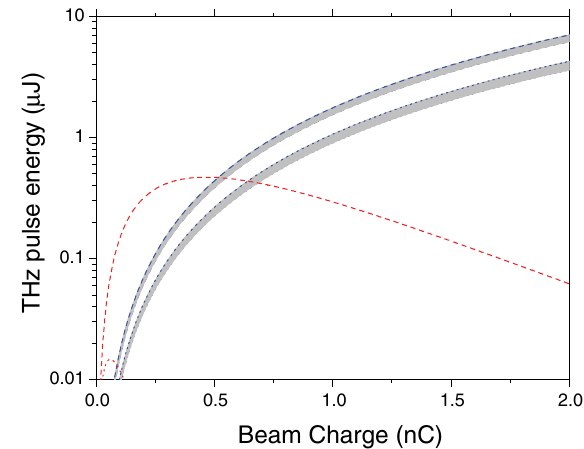
FIG. 10. Energy generated in a 1 = 16 bandwidth around a central frequency at 1.1 THz (dashed) and 2.2 THz (dotted) comparing the single bunch after bandwidth selecting filters (red) and the pulse train method